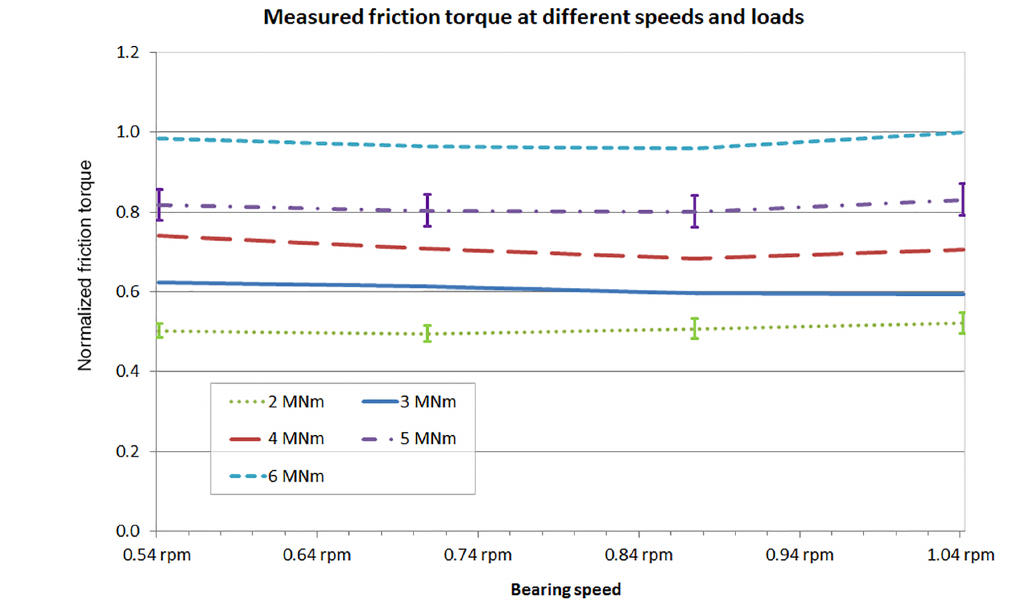
Figure 6. Measured friction torque at different speeds and